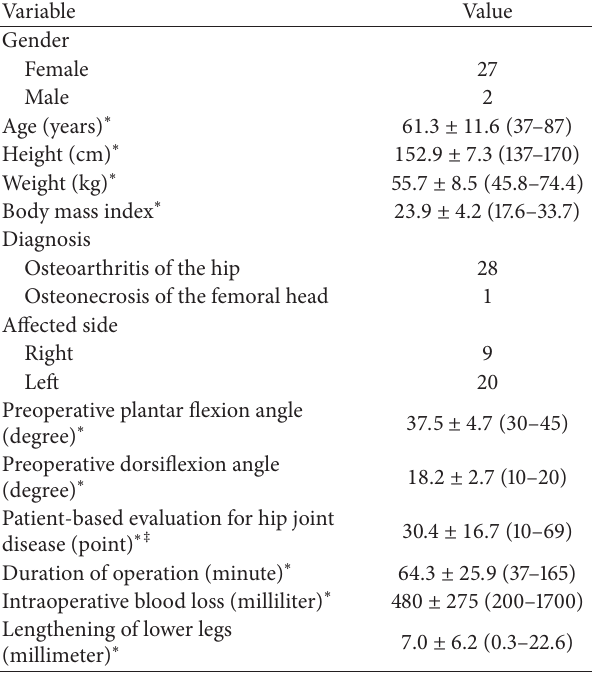
Table 1: Patient